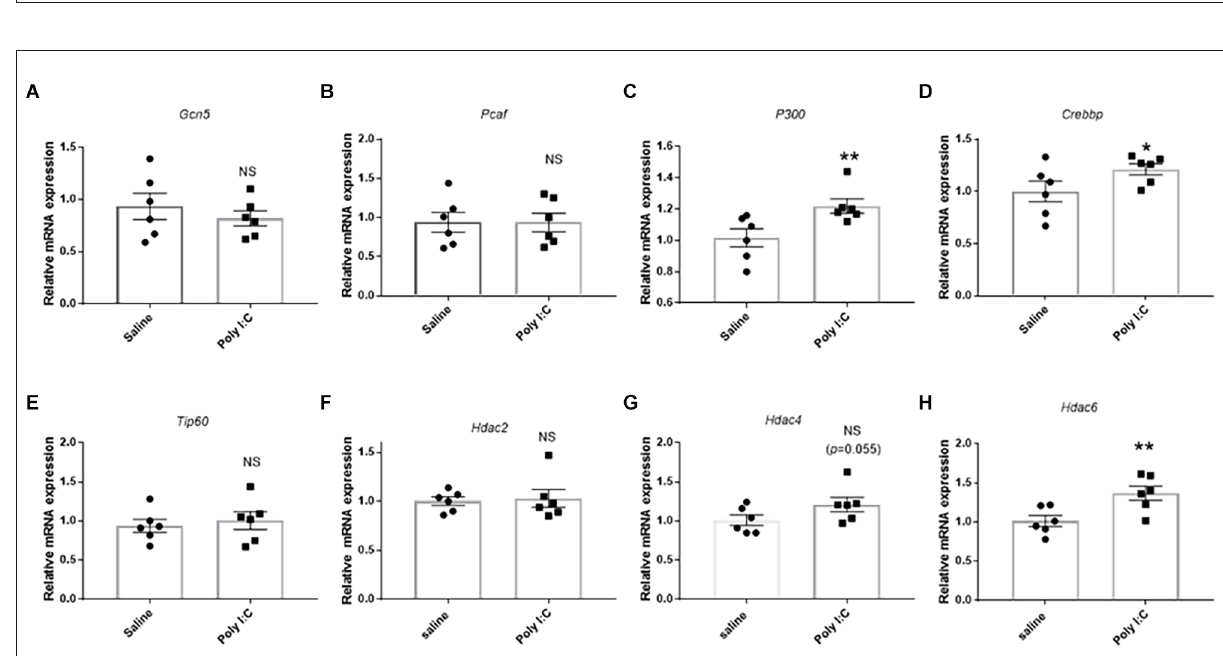
FIGURE3 Histone acetylation on the promoter region of the genes encoding neurotransmitter receptors. Enrichment of acetylated histone 3 on (A) the NMDA receptor subunit Grin2a and (B) 5-HT 2A receptor Htr2a , as well as enrichment of acetylated histone 4 on (C) the GABAA receptor subunits Gabrb3 . Data were presented as mean ± SEM ( n = 6/group). NS, no significance; Poly I:C vs. Control.